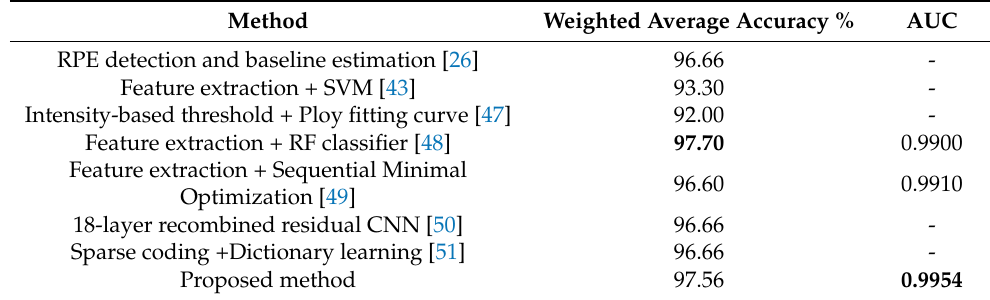
Table 6. Comparison of the proposed work with existing works conducted on the Duke